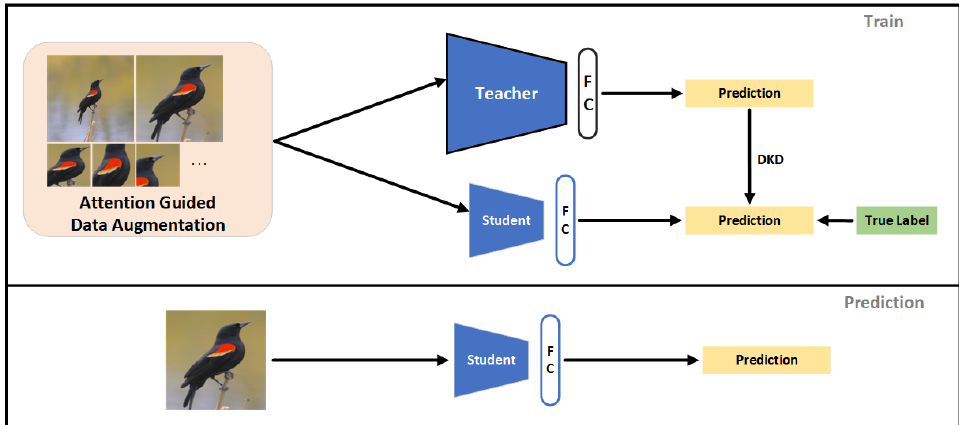
Figure 4. The training and prediction methods for the student models. In the training phase, five types of images, including the raw image, the object image, and the key part image acquired based on the teacher model and the object image and the key part image acquired based on the student model are used concurrently to train the student model as data after data enhancement. In the prediction phase, the object image acquired based on the student model is used as the final prediction output based on the idea of object localization and then